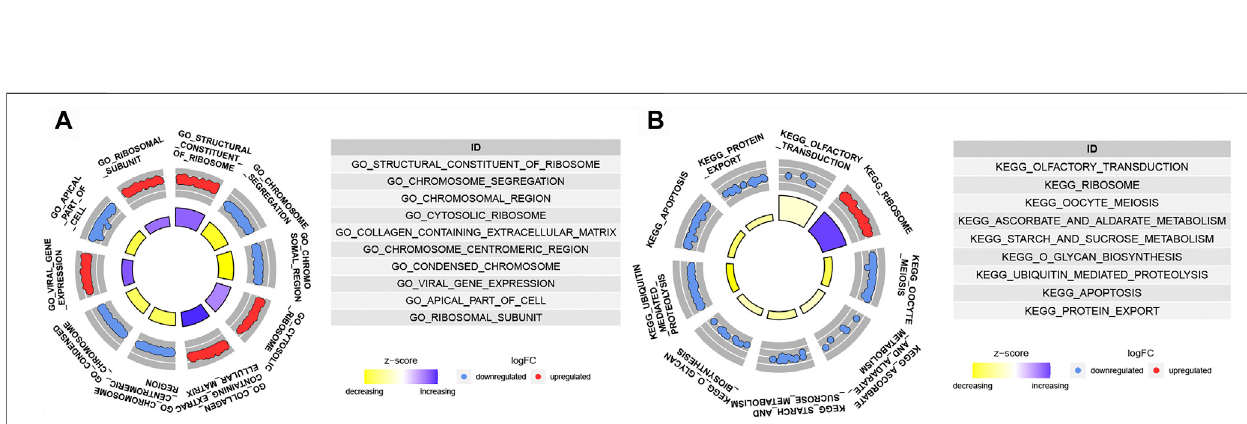
FIGURE 7 | Functional enrichment analysis. (A) GO items enriched by GSEA analysis in high risk group. (B) KEGG pathways enriched by GSEA analysis in high risk group.